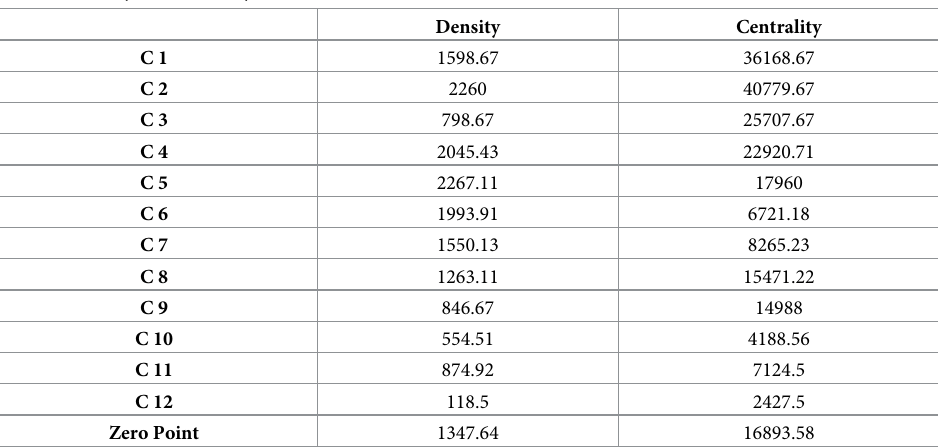
Table 4. Density and centrality value of each